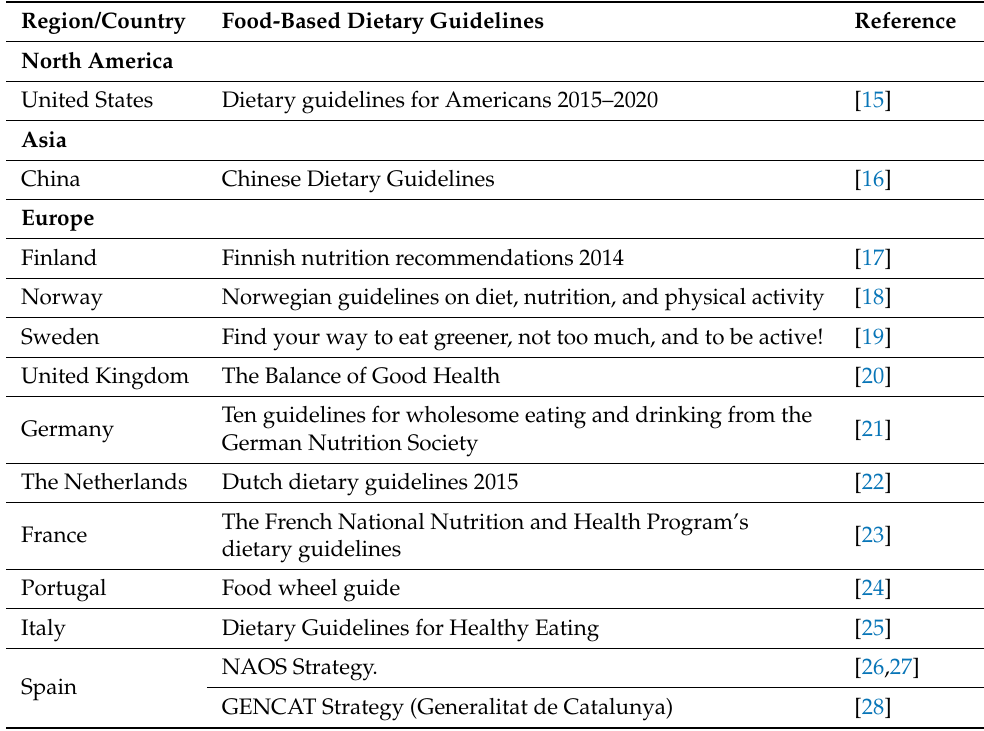
Table 1. International overview of Food-Based Dietary Guidelines established in North America (United States), Asia (China), and Europe (Finland, Norway, Sweden, United Kingdom, Germany, The Netherlands, France, Portugal, Italy, and Spain). Adapted from [5,14].